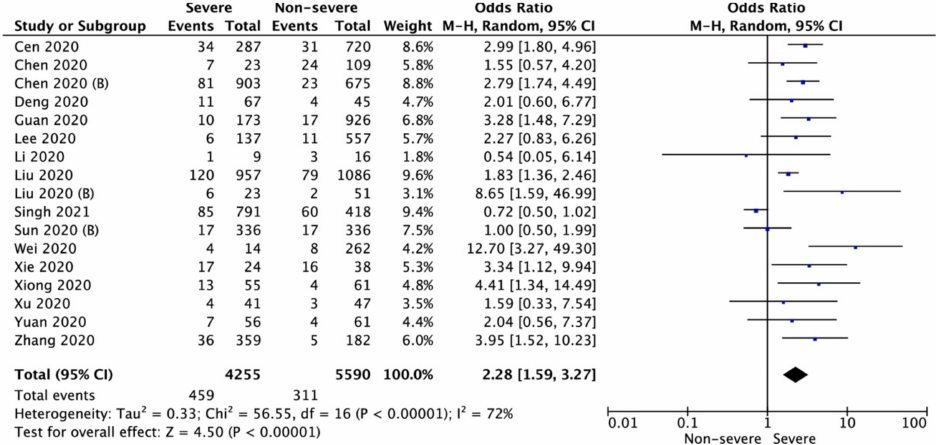
Figure 3. Forest plot of coronary artery disease occurrence in severe and non-severe COVID-19 patients. The center of each square represents the weighted odds ratios for individual trials, as the corresponding horizontal line stands for a 95% confidence interval. The diamonds represent pooled results.